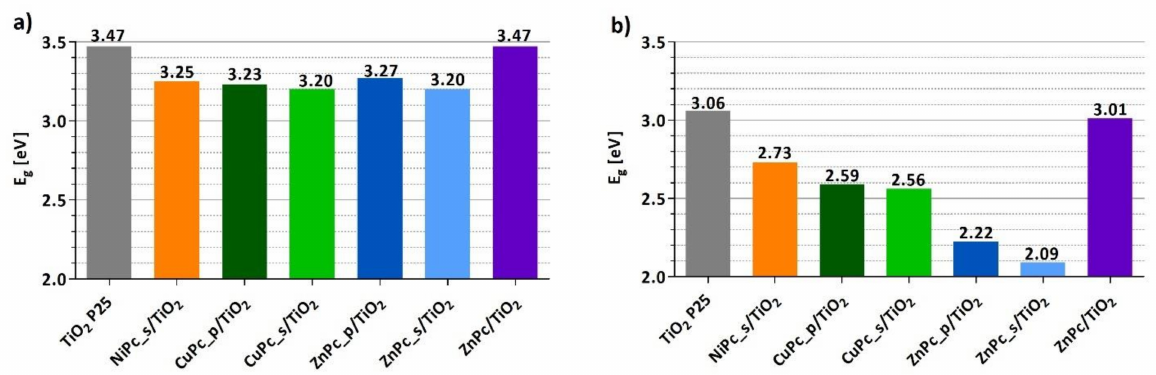
Figure 8. Band-gap energy values (E g ) of each photocatalytic material calculated from DRS measure- ments using the Kubelka–Munk equation and the Tauc plot method, assuming a direct transition ( a ) or an indirect transition ( b ).